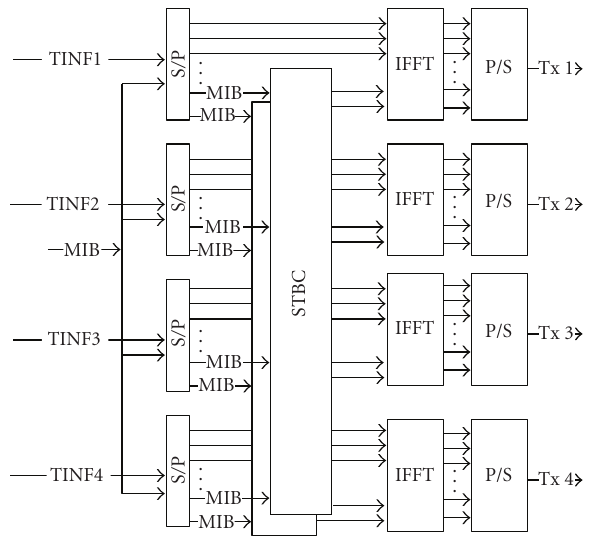
Figure 4: The block diagram of the proposed UEP